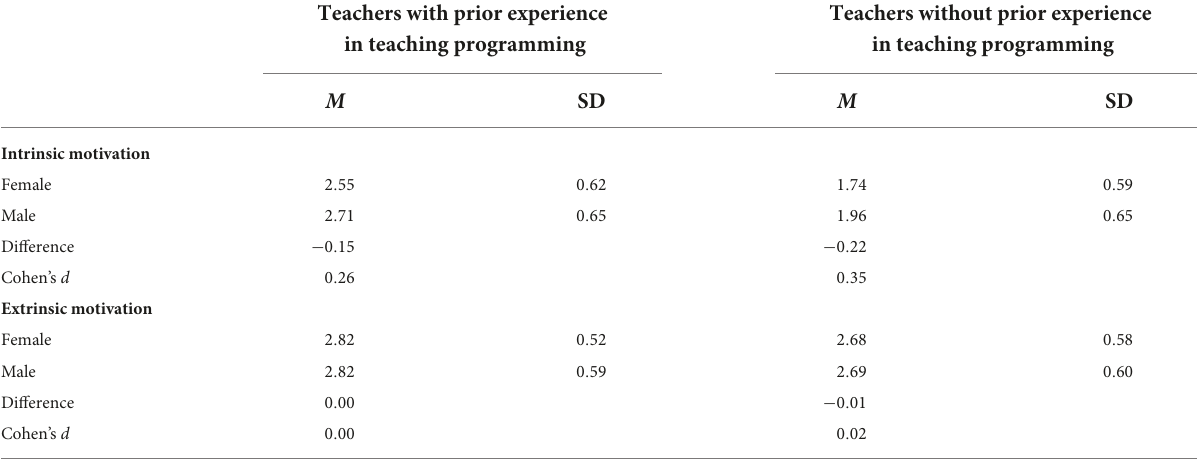
TABLE 6 Means and standard deviations, mean differences, and effect sizes (Cohen’s d ) of intrinsic and extrinsic motivation among the teacher respondents by gender and separately for teachers with and without programming experience.